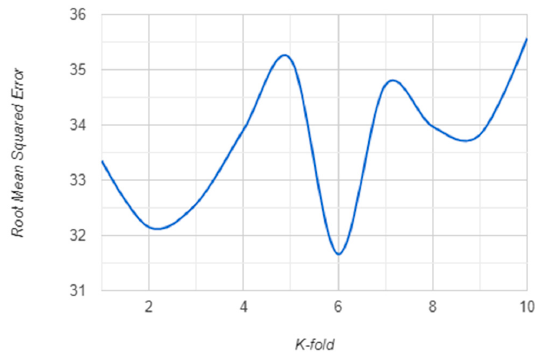
Figure 7. RMSE for 10-fold cross-validation of the random forest (RF) model.